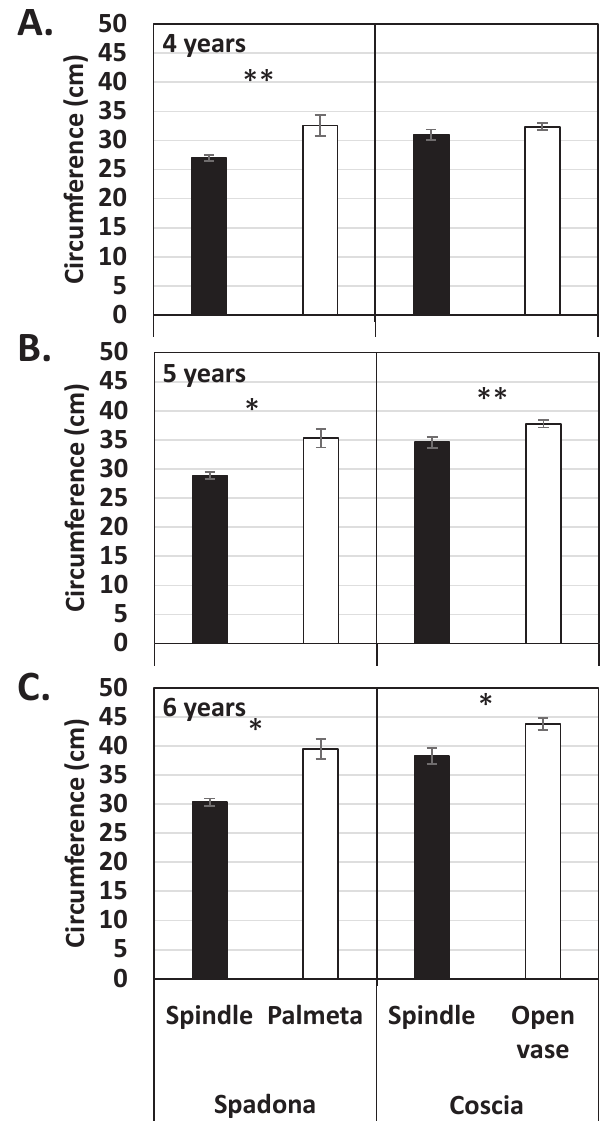
Figure 2. Mean trunk circumferences (cm) of 4-year-old (A), 5-year-old (B), or 6-year-old (C) pear trees. Trees were measured in November 2017 (A), 2018 (B), and 2019 (C), grown in a spindle design (low vigour, high density system for ‘Spadona’) , or Palmeta and open vase design (high vigour, low density system for ‘Coscia’). Results are presented as averages ± SE. * indicates P ≤ 0.01, and ** P ≤ 0.05, as shown by